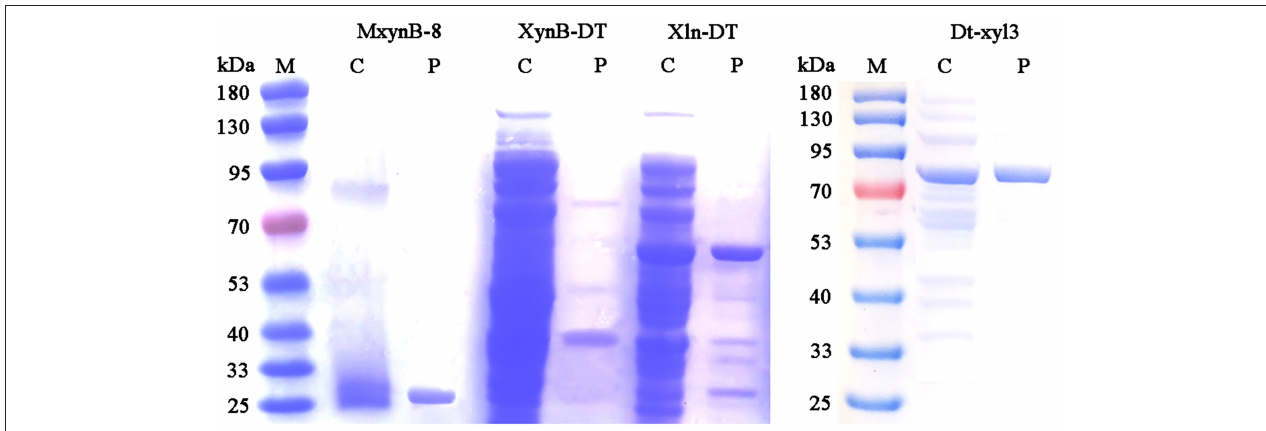
TABLE 1 | Purification of recombinant protein MxynB-8, XynB-DT, Xln-DT, and Dt-xyl3. Enzyme Culture extract Ni affinity chromatography Yield Specific Total Specific Total activity activity activity activity (mg) (U/mg) (mg)